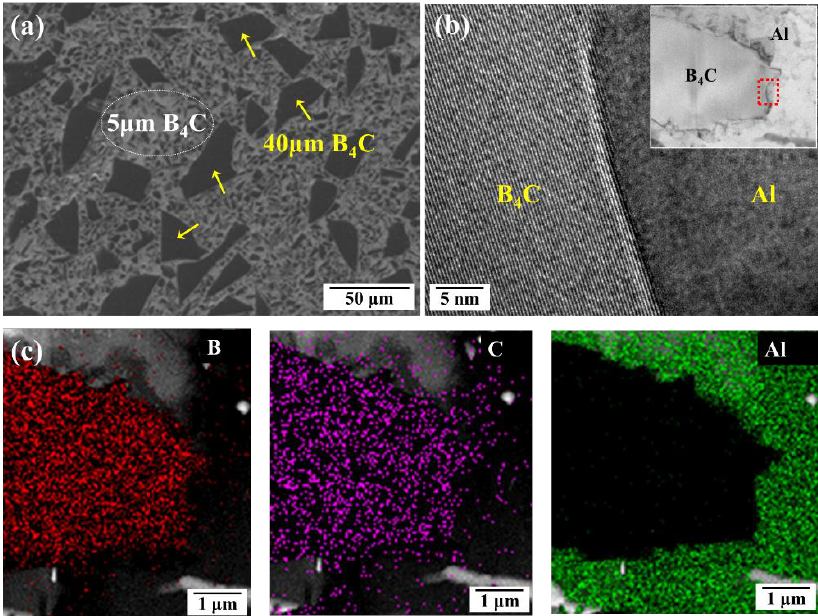
Figure 1. ( a ) Scanning electron microscopy (SEM), ( b ) field emission transmission electron microscopy (FE-TEM) and ( c ) transmission electron microscopy-energy dispersive spectrometry (TEM-EDS) images of bimodal B 4 C / Al7075 Al matrix composites (AMCs) fabricated by the liquid pressing process.